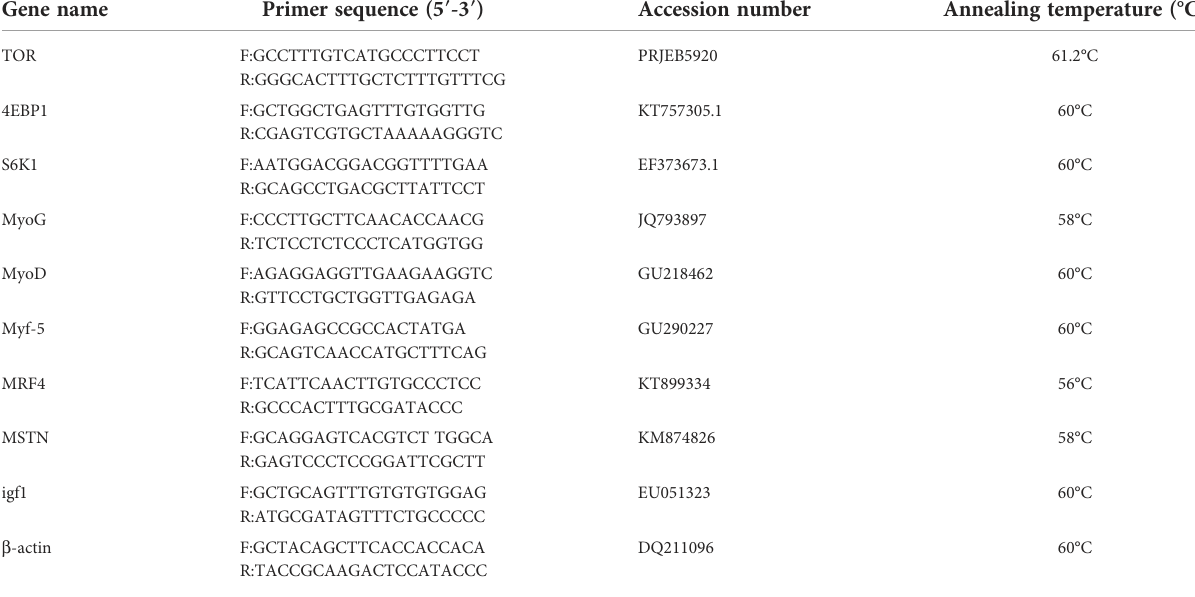
TABLE 3 Real-time primer sequences, accession numbers, and annealing temperature for studied